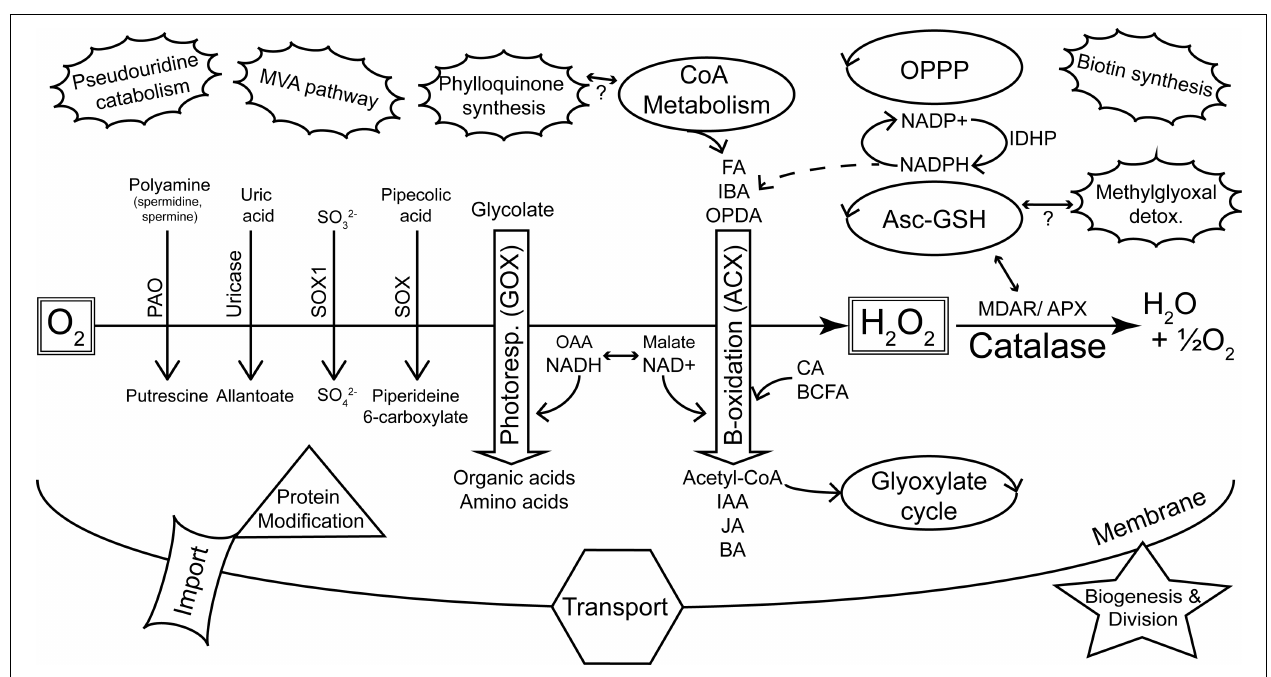
FIGURE 1 | Summary of major metabolic pathways and processes of plant peroxisomes as identified by proteomics. The peroxisome plays a key role in sequestering reactions that evolve reactive oxygen species (de Duve, 1969a).This is highlighted by the diverse oxidases (downward pointing arrows) that generate H 2 O 2 , and the detoxification of ROS by catalase and other enzymes. Photorespiration and β -oxidation are emphasized in the center of the figure as the major pathways.The dehydrogenases of β -oxidation are primarily dependent on NAD + as an electron acceptor. Hydroxypyruvate reductase (HPR) of photorespiration requires NADH and this shift in redox requirements is depicted by the interchange between OAA/NADH on the one hand and malate/NAD + on the other. NADPH is also required by β -oxidation for pathways including unsaturated FA catabolism and JA synthesis. Peroxisome-localized pathways (e.g., glyoxylate cycle, CoA metabolism, OPPP, Asc-GSH cycle) that can be linked with classic peroxisome